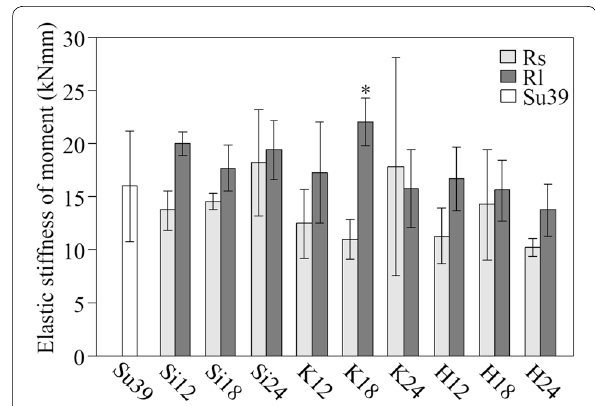
Fig. 7 Averages of the effect of the reinforcement on the elastic stiffness of the moment. The error bar indicates the standard deviation. *: Significant at 5% level, **: significant at 1% level. The letters, such as Si12, represent the specimen specifications, as follows: the first letters represent the wood species with Si, K, H, and Su representing shirakashi, kuri, hinoki, and sugi, respectively, and the number represents the height of the reinforcement